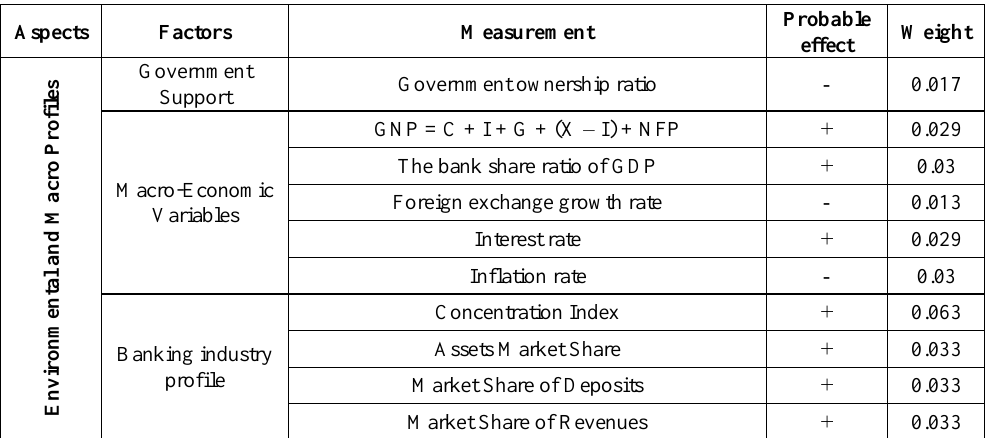
Table 2. Suggested Comprehensive Rating